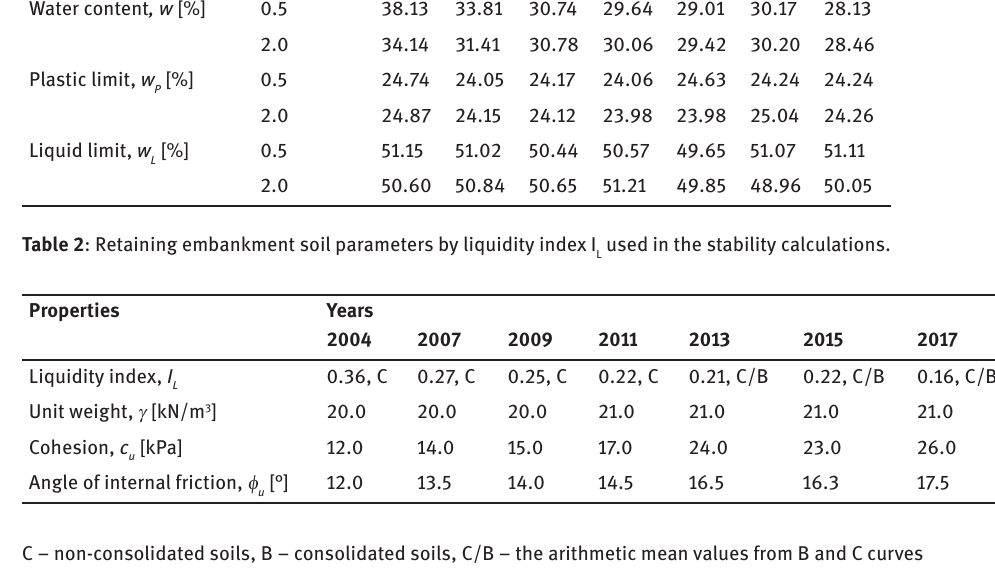
Table 1 : Laboratory test results in successive years (mean values from three boreholes). Properties